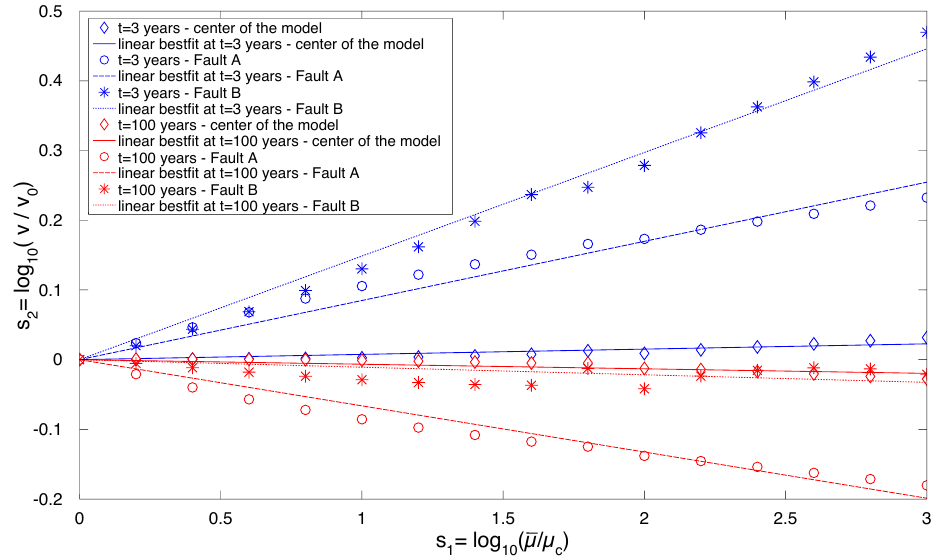
Figure 11. Uplift variations against variations in rigidity at faults for Scenario III. Decreasing the rigidity by s 1 orders of magnitude (i.e. dividing the rigidity by 10 s 1 ), the corresponding uplift changes by s 2 orders of magnitude (i.e. by a factor of 10 s 2 ). Blue lines refer to the simulation at t = 3 years, while red lines refer to t = 100 years. Variation in uplift is computed at the centre of the model r = z = 0 (diamonds), Fault A (circles) and Fault B (stars). Linear best fits (constrained through the origin s 1 = s 2 = 0) are represented by solid, dashed and dotted lines for the centre of the model, Fault A and Fault B, respectively. The slopes of the best fit lines for simulations at t = 3 years are about 0.0849 for Fault A, 0.149 for Fault B and 0.00756 at the centre of the model, while for simulations at t = 100 years are about − 0.0663 for Fault A, − 0.0108 for Fault B and − 0.00656 at the centre of the